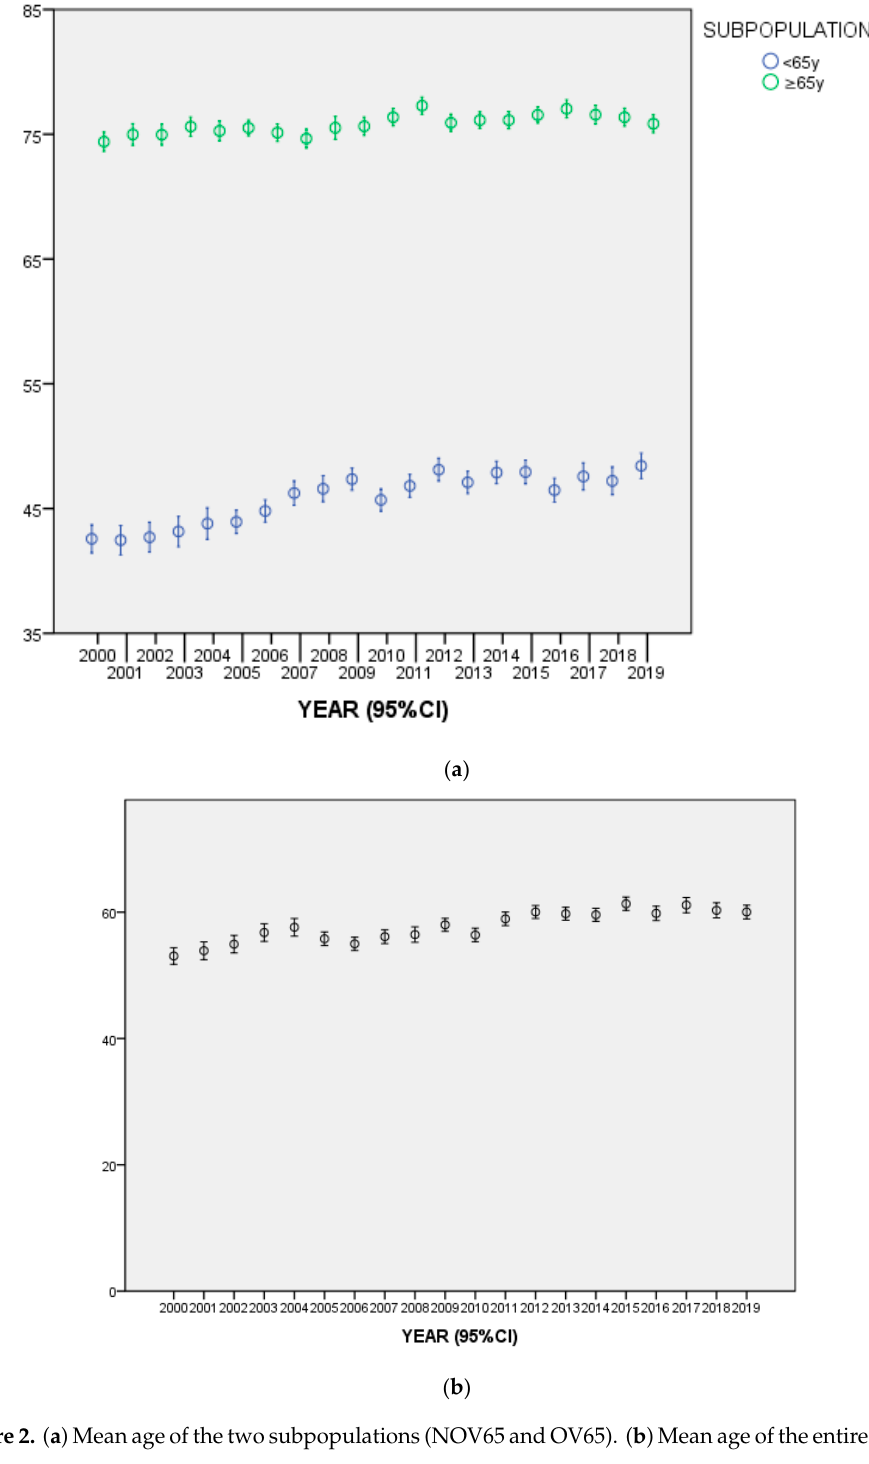
Figure 2. ( a ) Mean age of the two subpopulations (NOV65 and OV65). ( b ) Mean age of the entire